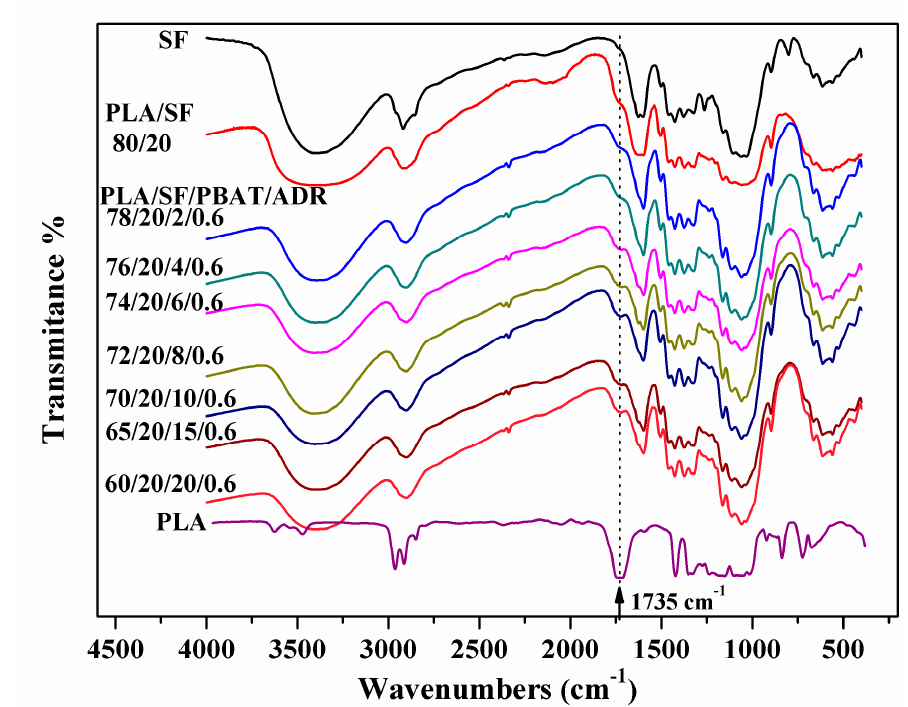
Figure 6. Fourier Transform infrared spectroscopy (FTIR) spectra of alkaline-treated SF, extracted SF from composites, and PLA